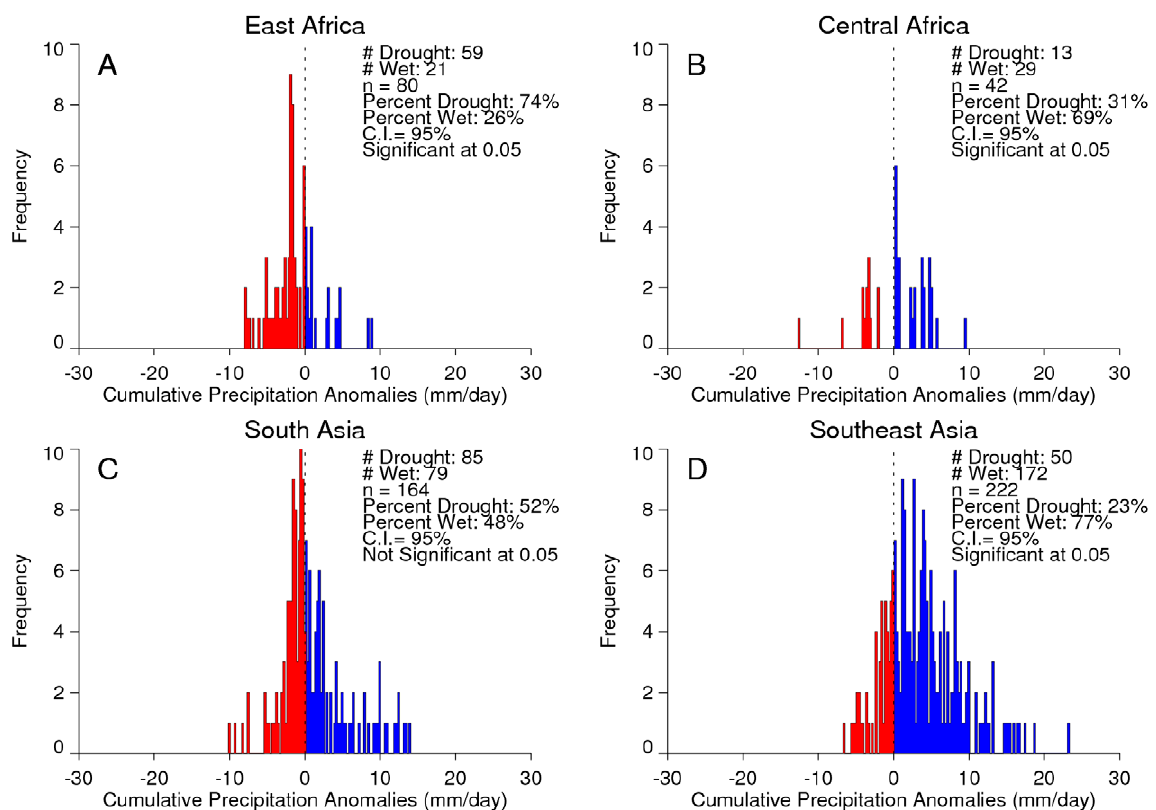
Figure 7. Frequency distributions of chikungunya outbreak events in relation to precipitation. Frequency distributions of chikungunya outbreak events and 4-month cumulative precipitation anomalies for East Africa (A), Central Africa (B), South Asia (C), and Southeast Asia (D). The 4- month anomaly threshold was used to represent periods of either persistent above-normal rainfall/wetness or persistent drought conditions. The dashed line at zero depicts the (1979–2009) long term rainfall, with greater-than-normal precipitation shown to the right (blue) and lower-than- normal precipitation shown to the left (red) of the line. Cases shown to the left of the dashed line occurred during periods of drought with a persistence of 4